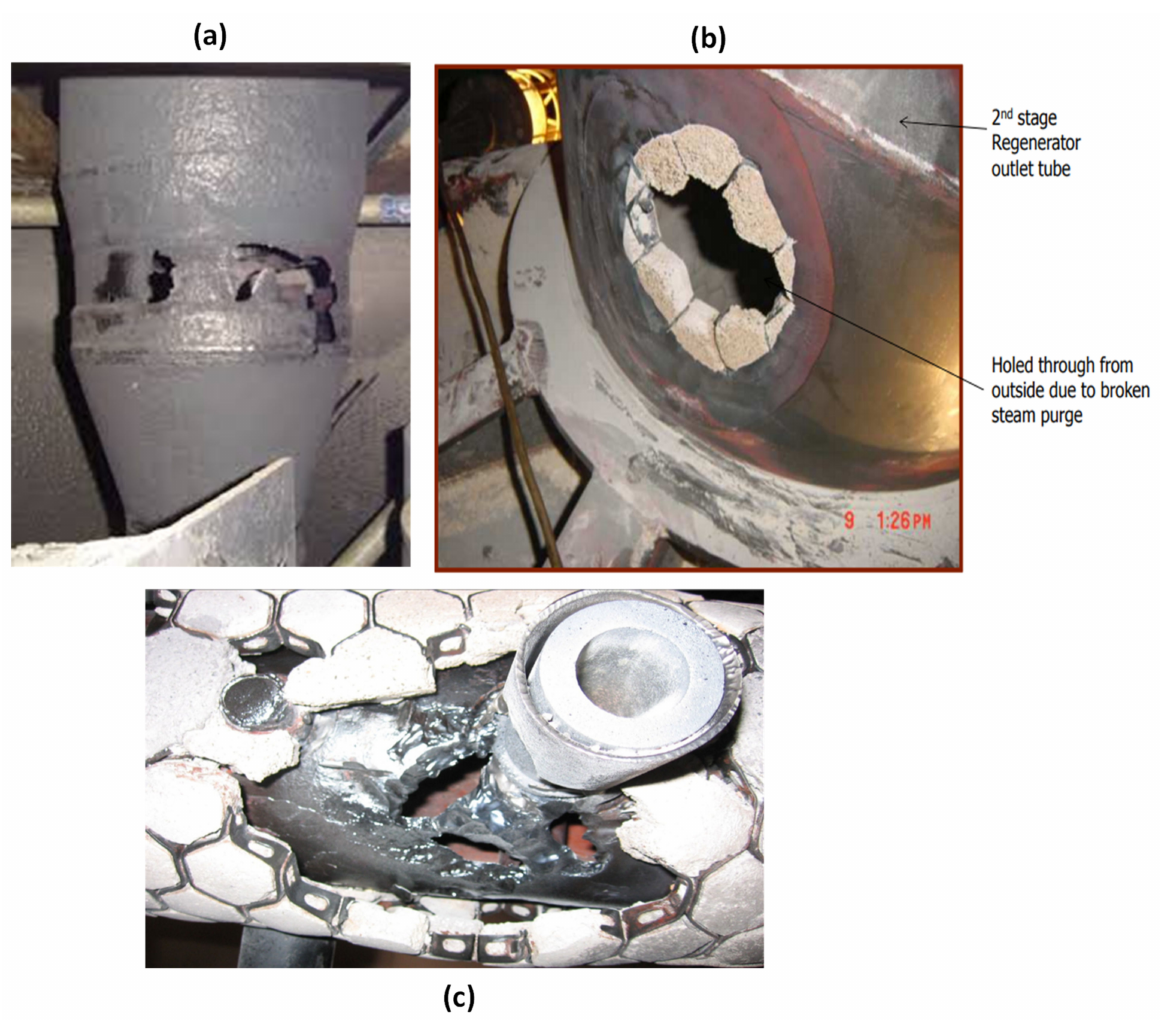
Figure 23. Severe high-temperature erosion impacts. ( a ) Cyclone inside-out wear; ( b ) steam purge inside-out wear; ( c ) eroded air distributor nozzle. Adopted from Chen [133] and Willbourne [225]. Erosion mechanisms vary from unit to unit. For cyclone separators, Chen [133] attributed high temperature, catalyst loading and gas velocity as surface erosion driving forces. Knowlton and Reddy Karri [48] asserted that due to low solids flux in the secondary cyclones, erosion rates are comparably low relative to primary cyclones, which is